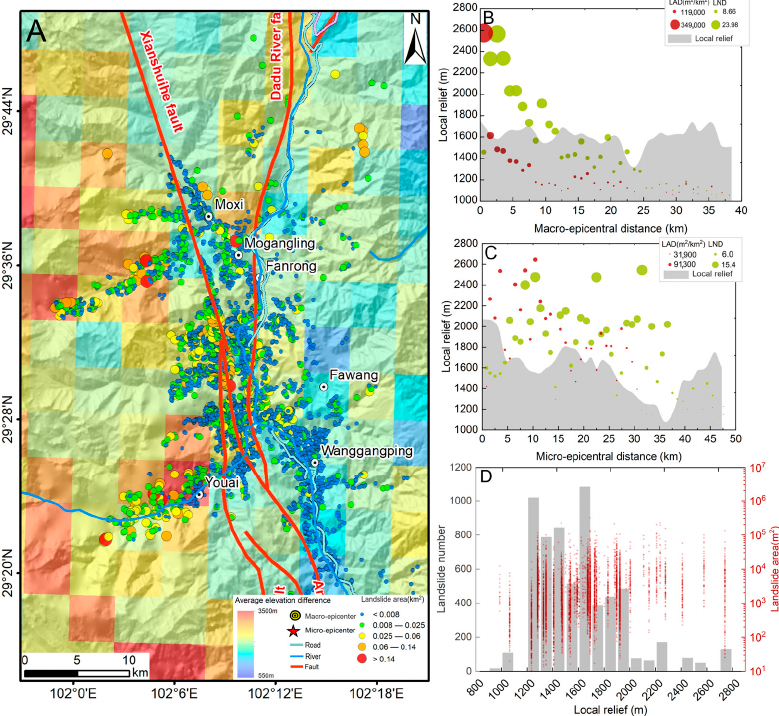
Figure 12. ( A ) coseismic landslide distribution with local relief; ( B , C ) local relief with macro- and micro-epicentral distance; ( D ) individual landslide distribution with local relief.